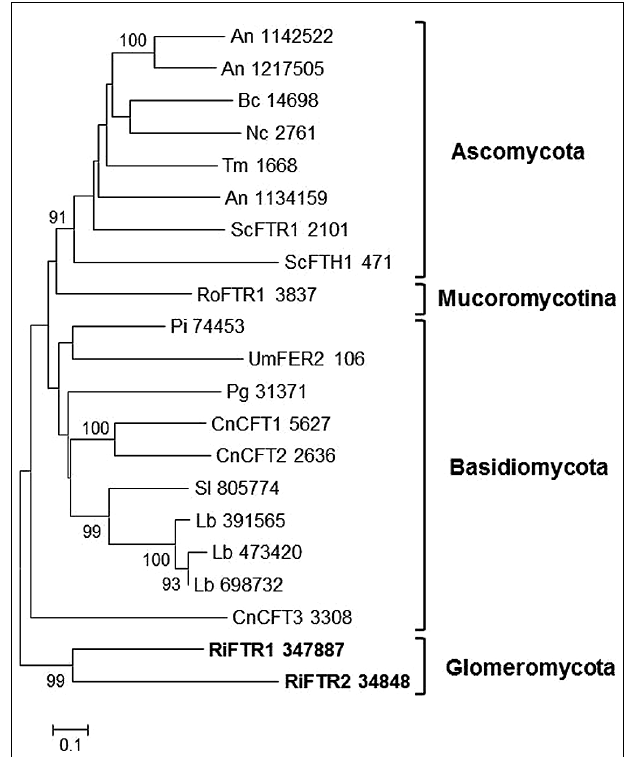
FIGURE 4 | Phylogenetic relationships of the Rhizophagus irregularis iron permeases (FTR) with homologous sequences from selected species representative of the major fungal phyla. The Neighbor-Joining tree was created with MEGA 6. Protein JGI identification numbers are indicated. R. irregularis genes are shown in bold. Organisms: An, Aspergillus niger ; Bc, Botrytis cinerea ; Cc, Coprinopsis cinerea ; Cn, Cryptococcus neoformans ; Lb, Laccaria bicolor ; Nc, Neurospora crassa ; Pi, Piriformospora indica ; Pg, Puccinia graminis ; Sc, Saccharomyces cerevisiae ; Sl, Suillus luteus ;Tb, Tuber melanosporum; Ri, Rhizophagus irregularis ; Ro, Rhizopus oryzae ; Um, Ustilago maydis . Bootstrap values above 70 and supporting a node used to define a cluster are